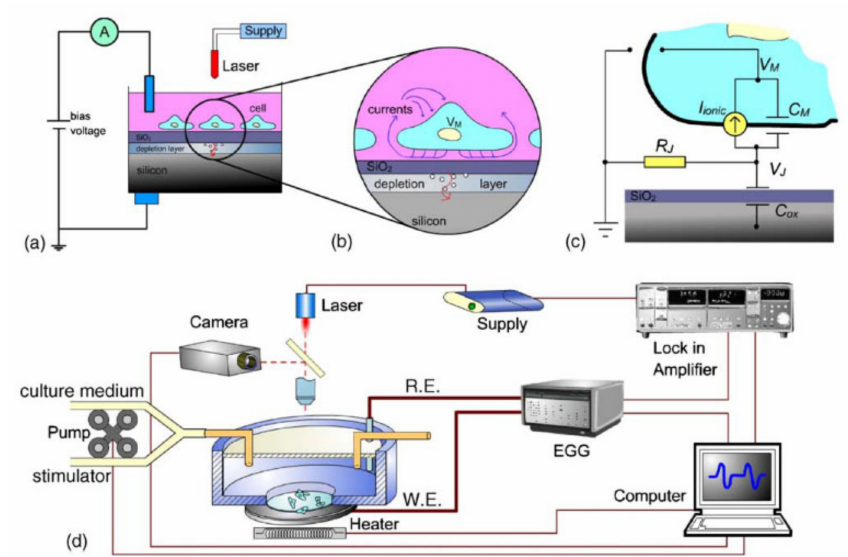
Figure 3. An example of a sensor-based on olfactory cells ( a ) with a detail of cell interfacing with transducer ( b ) and circuitry involved ( c ). A broader scheme of the experiments is reported ( d ). Reproduced from [91] with permission from Elsevier (License number